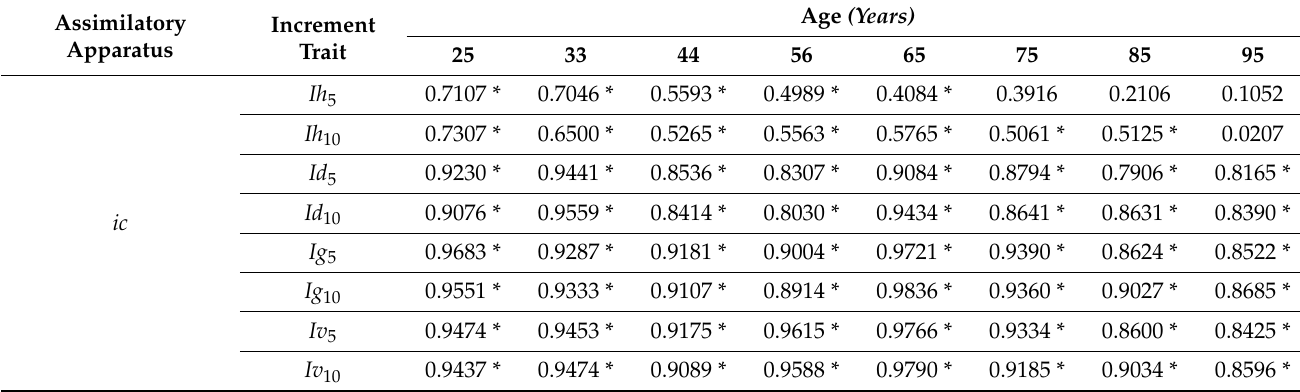
Table 8. Values of linear correlation coefficients r between needle weight ( ic ) and increment traits ( Ih 5 , Ih 10 , Id 5 , Id 10 , Ig 5 , Ig 10 , Iv 5 , Iv 10 ) depending on the age of the